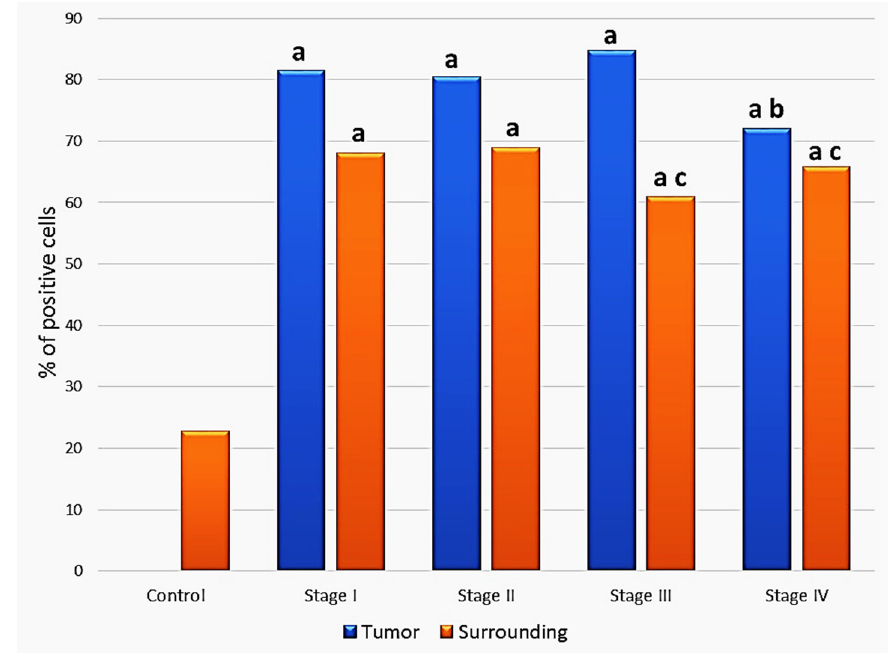
Figure 4. Comparison of the HNE immunopositivity in the cytoplasm of squamous carcinoma cells and in non-malignant epithelial cells adjacent to the tumor depending on the clinical stage of the disease. a—significance to the healthy controls subjects; b—significance to the cancer cells of the stage III carcinoma specimens; c—significance to the non-malignant cells surrounding cancer tissue graded as stage I or II.